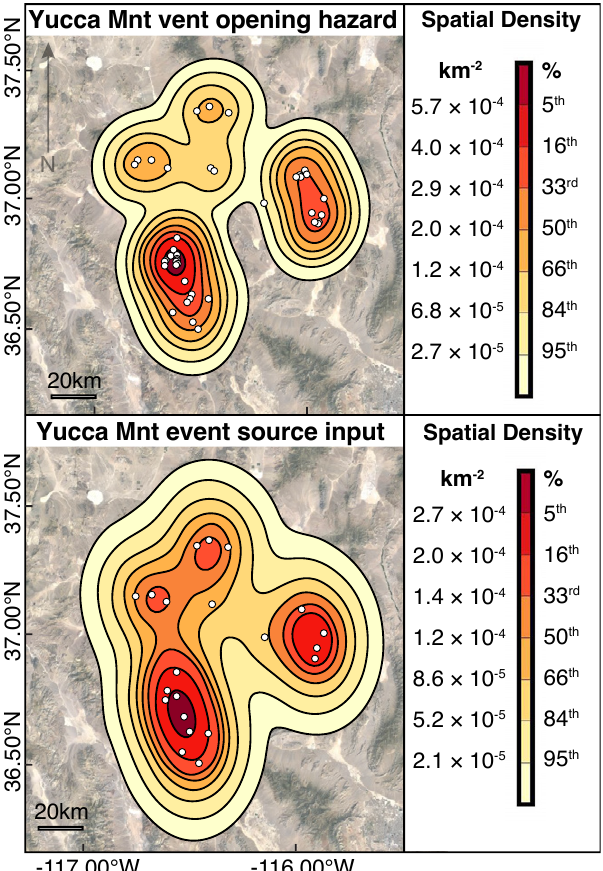
Figure 8: Vent opening hazard map and event eruptive source parameter input map for Yucca Mountain. Map background data: Google, Landsat/Copernicus.